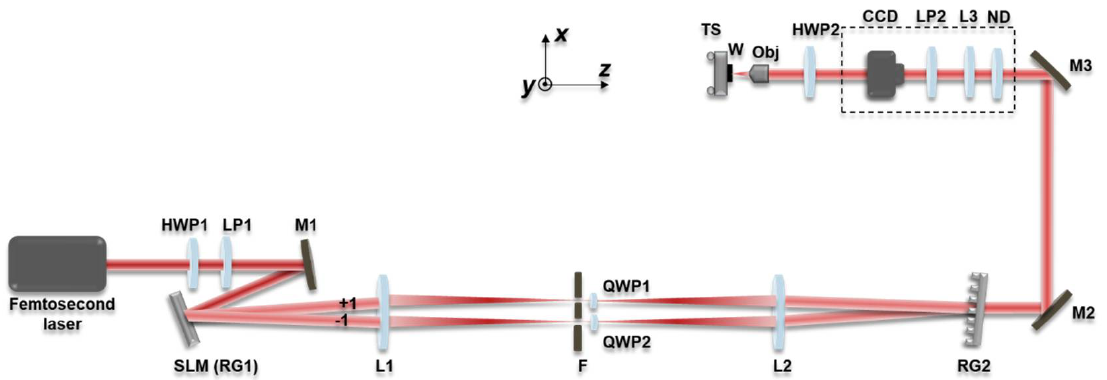
Figure 1. Experimental setup of fabricating the compound subwavelength surface patterns by femtosecond vector beam irradiation of the tungsten target (top view). HWP: half-wave plate, LP: linear polarizer, M: high reflectance mirror, SLM: spatial light modulator, RG: Ronchi grating, L: plano-convex lens, F: pinhole filter, QWP: quarter-wave plate, ND: neutral density filter, Obj: 10× objective, W: tungsten sample, TS: electric controlled translation stage.